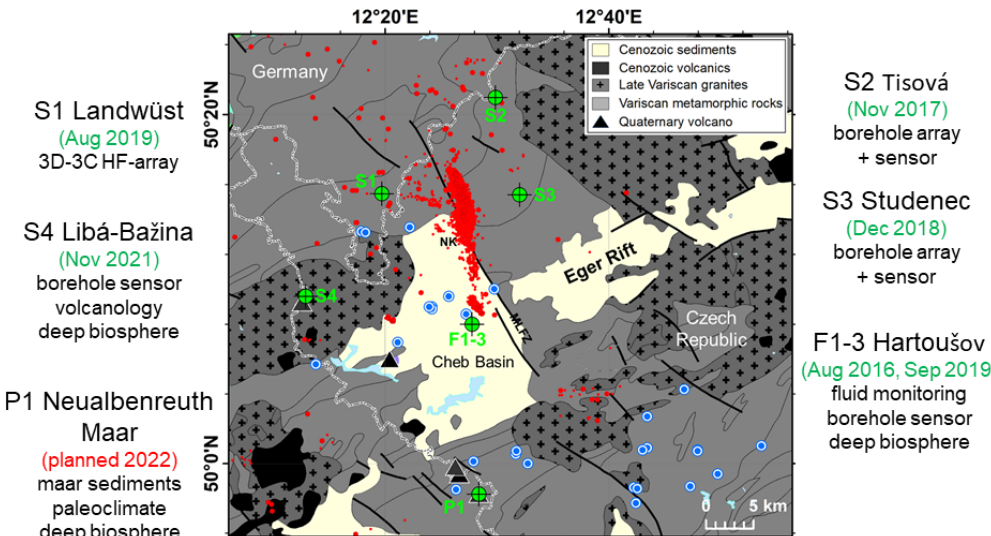
Figure 2. The drilling sites and their prime scientific targets: S1 – Landwüst, S2 – Tisová, S3 – Studenec (seismological monitoring), S4 – Libá (seismological monitoring, volcanology and the deep biosphere in volcanic maar crater), F1–3 – Hartoušov (fluid, earthquake and deep-biosphere monitoring) and P1 (a planned borehole for paleoclimate and biosphere investigation). The time of realization is indicated in parentheses. Red circles represent the seismicity of the main Nový Kostel (NK) focal zone; blue circles represent mofettes and mineral springs with a gas discharge of more than 1Lmin − 1 ; Quaternary volcanoes are indicated by black